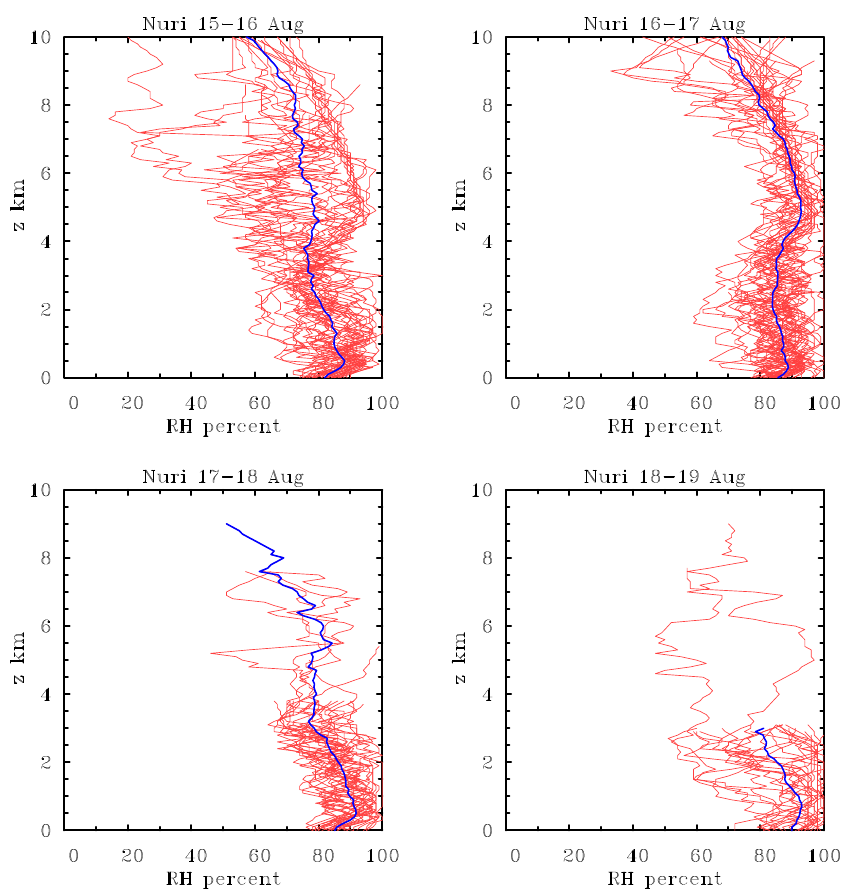
Fig. 4. Vertical profiles of relative humidity (RH) for each usable sounding on all days of Nuri. The system-average RH is depicted by the solid blue curve. The mean sounding for the last day of observations is plotted only up to 3 km height since the two soundings that extend to higher levels are located outside of the storm.